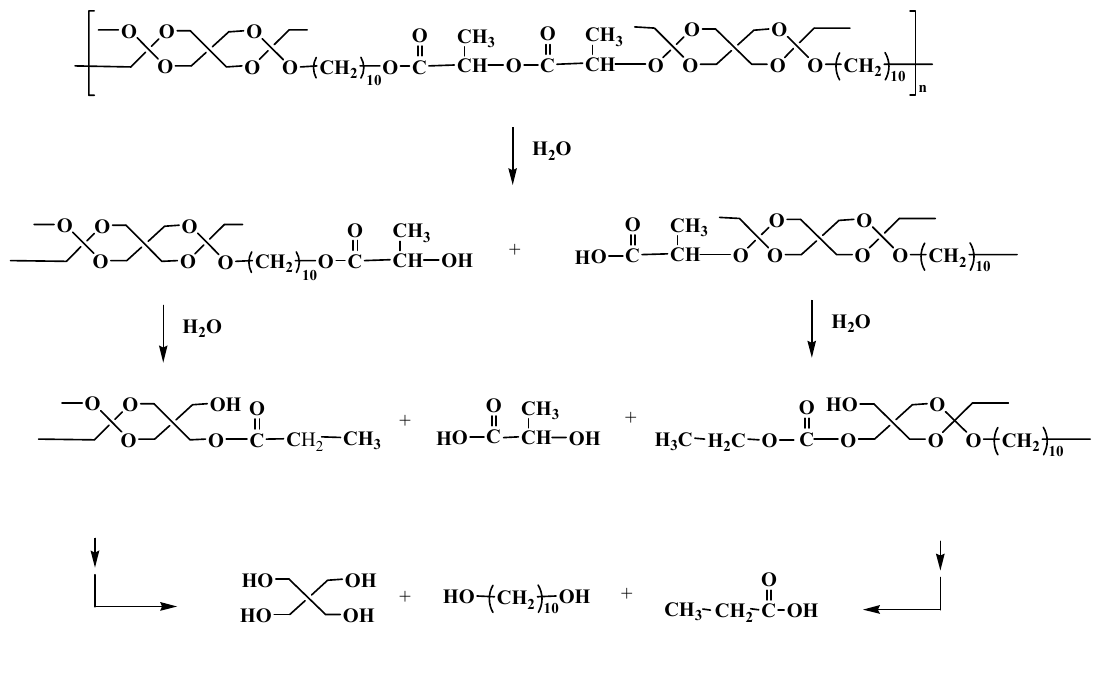
Figure 5. Hydrolysis pathway of POE IV under aqueous